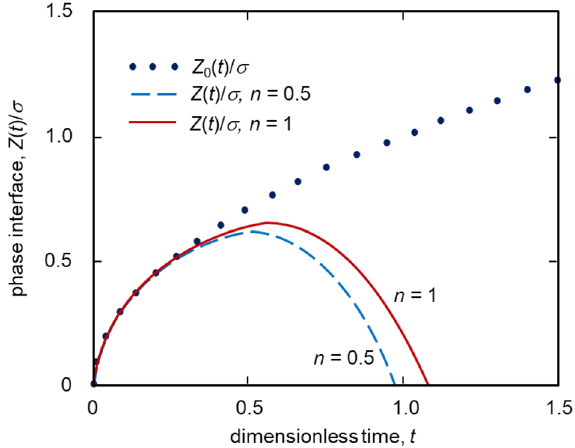
Figure 2. Rescaled phase interface Z ( t )/σ as a function of dimensionless time t at different n . The dotted and solid curves respectively show zero and first approximations of the interface position. Physical parameters 3 3 1 1 1.58 10 10 J m 400 426.77 J kg 7 10 3 kg m used for calculations are 30 : ρ , c K − , Q v , (cid:31) T 0 − − − = × = = = × 10 1 1 1 1 4 1 , µ 41.84 J s 4.47 10 2 , (cid:31) 10 , w 10 K, p m − K − , β k m s − K − n , ℓ m, − − − = = × = = = 4 ∞ = − 1.12 10 8.44 10 4 , τ 0.5 (dashed σ s. The phase interface as a function of time t is plotted for n o = − × = × = 1 (solid line). The dotted line representing the main contribution Z 0 ( t )/σ is independent of n . line) and n =